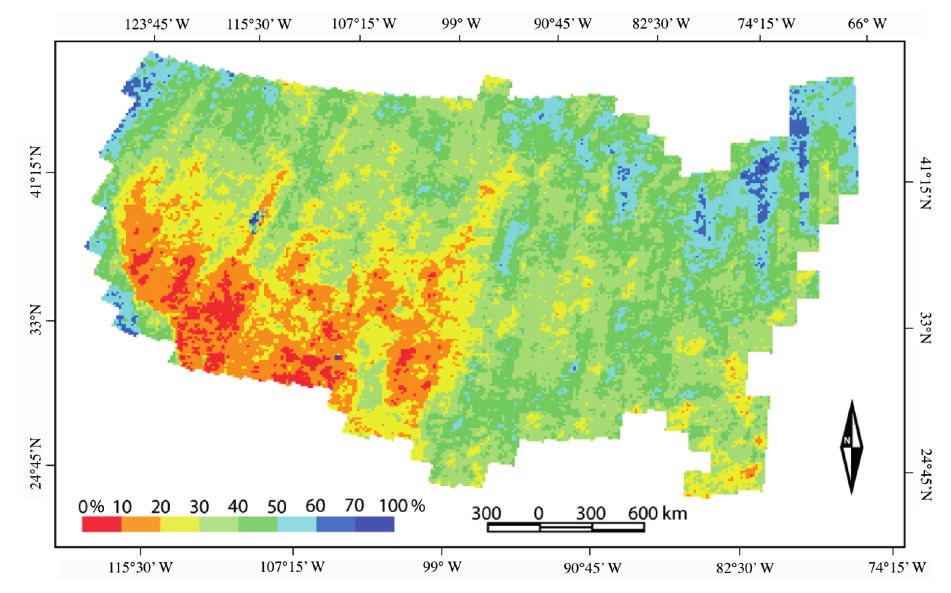
Figure 2. Percentage of high confidence cloud detections over 53 weeks of Landsat 8 observations derived at each 30 m conterminous US Albers projection pixel location. For visualization purposes the median percentages in 43,593 non-overlapping 15 × 15 km gridcells are shown.